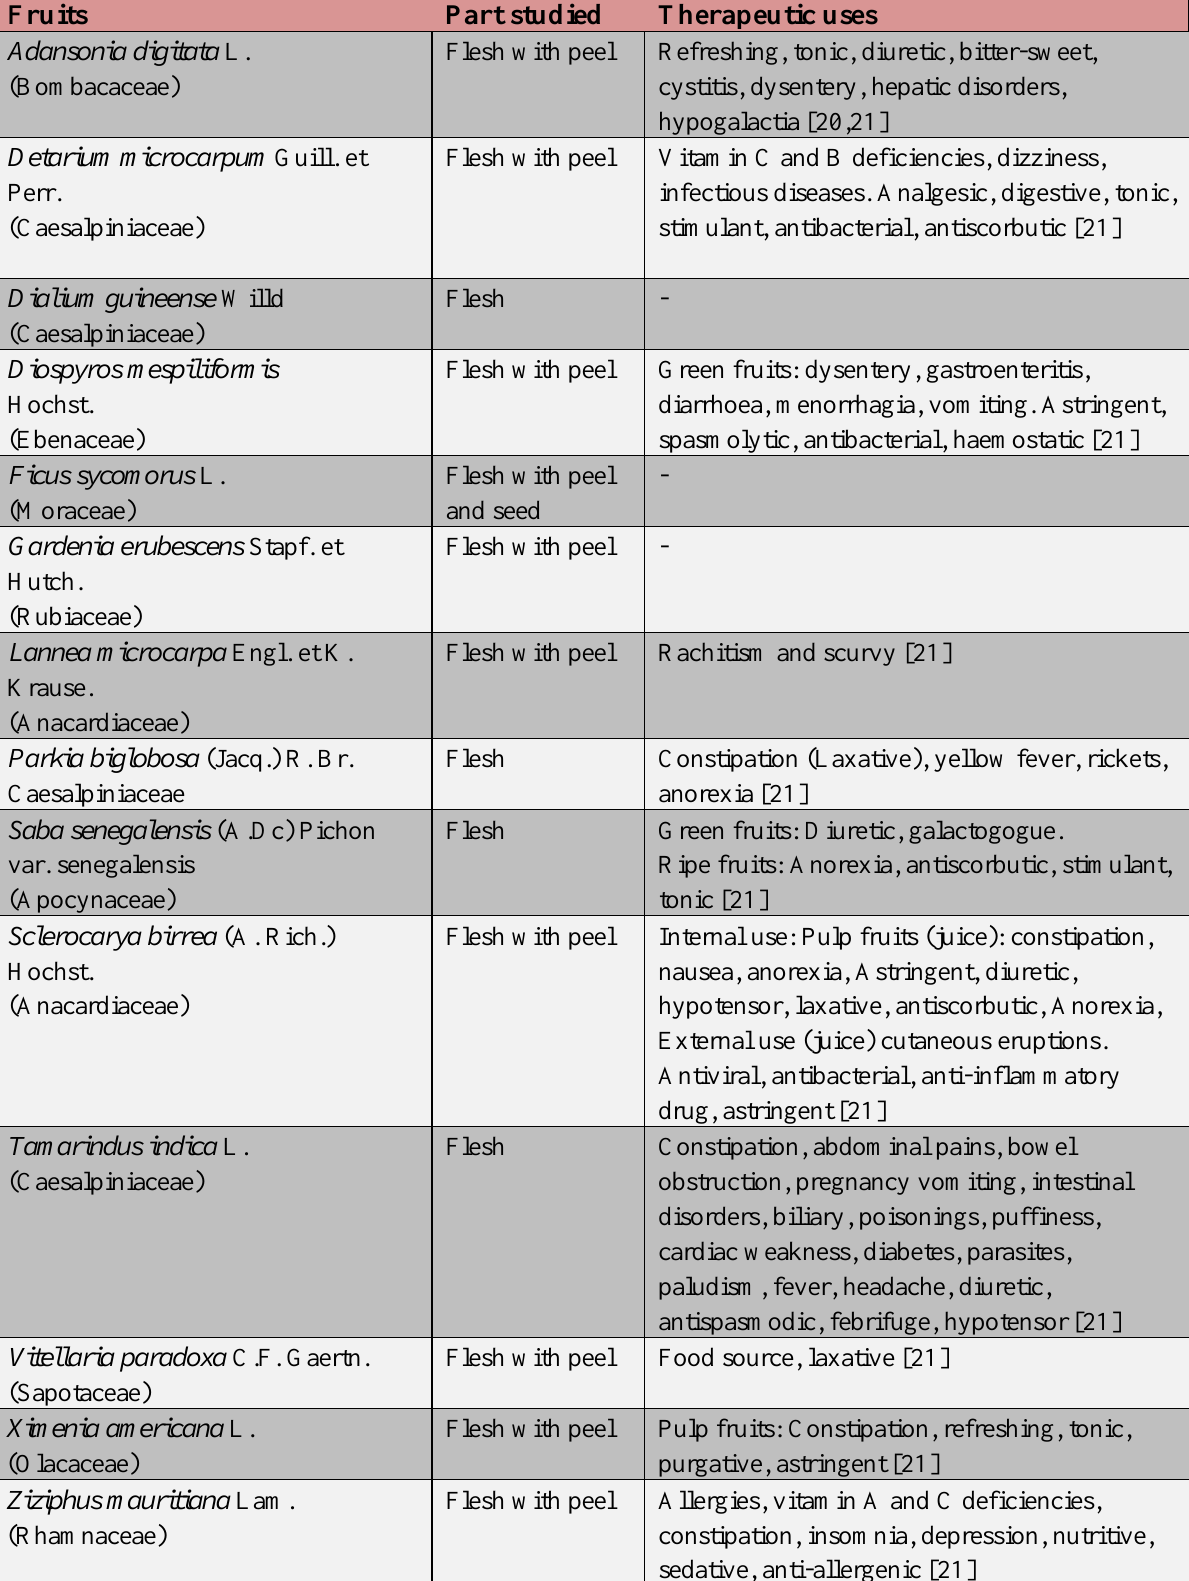
Table 1. Therapeutic uses of some of the studied edible